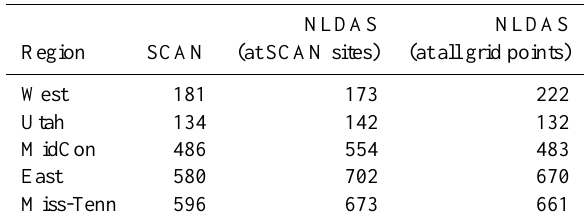
Table 2. Total SCAN and NLDAS precipitation (mm) for the study period (1 May–15